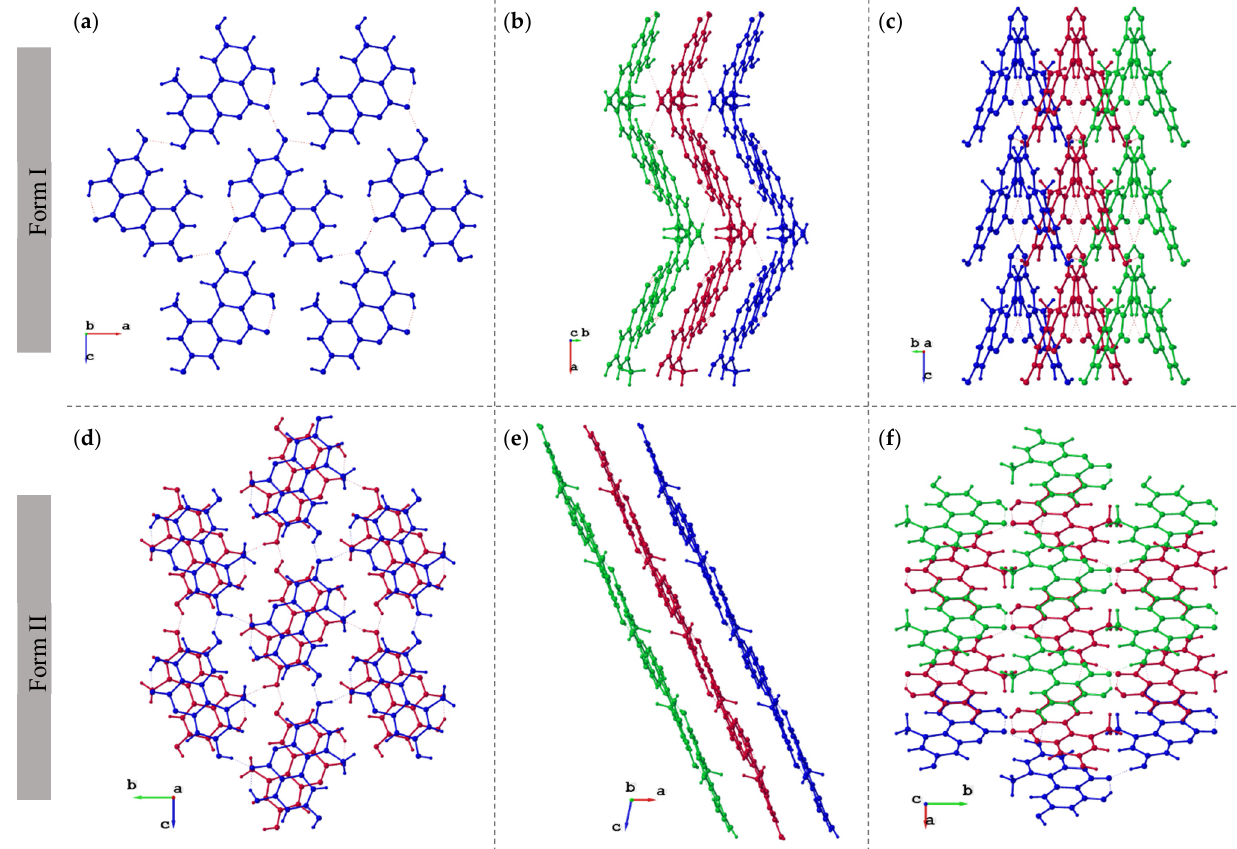
Figure 5. Crystal packing diagrams of Form I (upper) and Form II (lower) at different orientations. Left column ( a and d ): views perpendicular to molecular planes; Middle column ( b and e ): side views of the molecule; Right column ( c and f ): the same layers of 5b and 5e rotated by 90°.